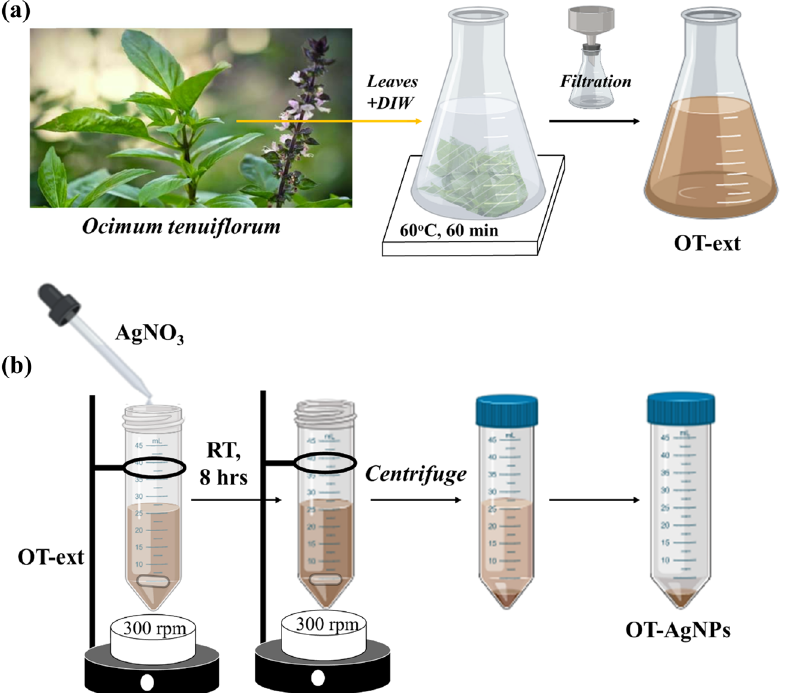
Figure 1: Preparation procedure of the O. tenui fl orum leaf extract ( OT - ext ) ( a ) and biosynthesized AgNPs ( OT - AgNPs ) fabricated by OT - ext ( b ) ( rpm: rings per minute )